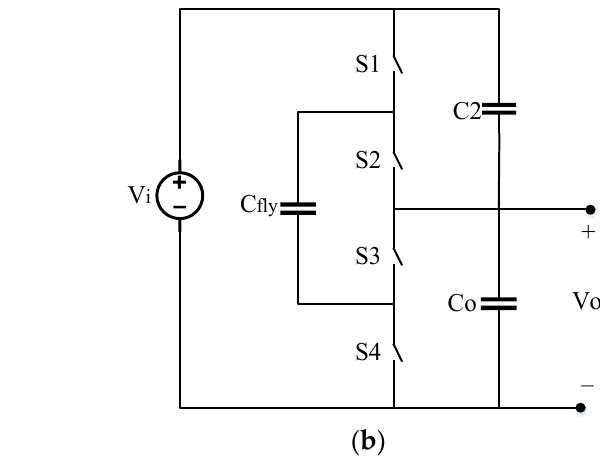
Figure 9. ( a ) Boost and ( b ) buck ladder converters.